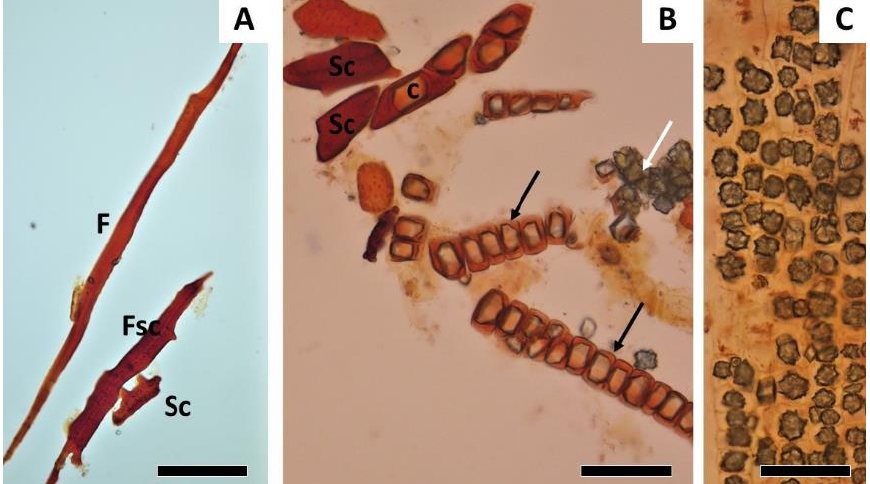
Figure 6. Individualized cells of the bark of Quercus rotundifolia . ( A ) Sclerenchyma tissue: secondary fibers (F), fibrosclereid (Fsc), and sclereid (Sc); ( B ) sclereid (Sc), sometimes with a prismatic crystal (c), series of parenchyma crystalliferous cells (black arrow), and druses (white arrow); ( C ) innumerous druses in nonlignified parenchyma cells. Scale bar: A = 80 μm; B = 50 μm; C = 50 μm.